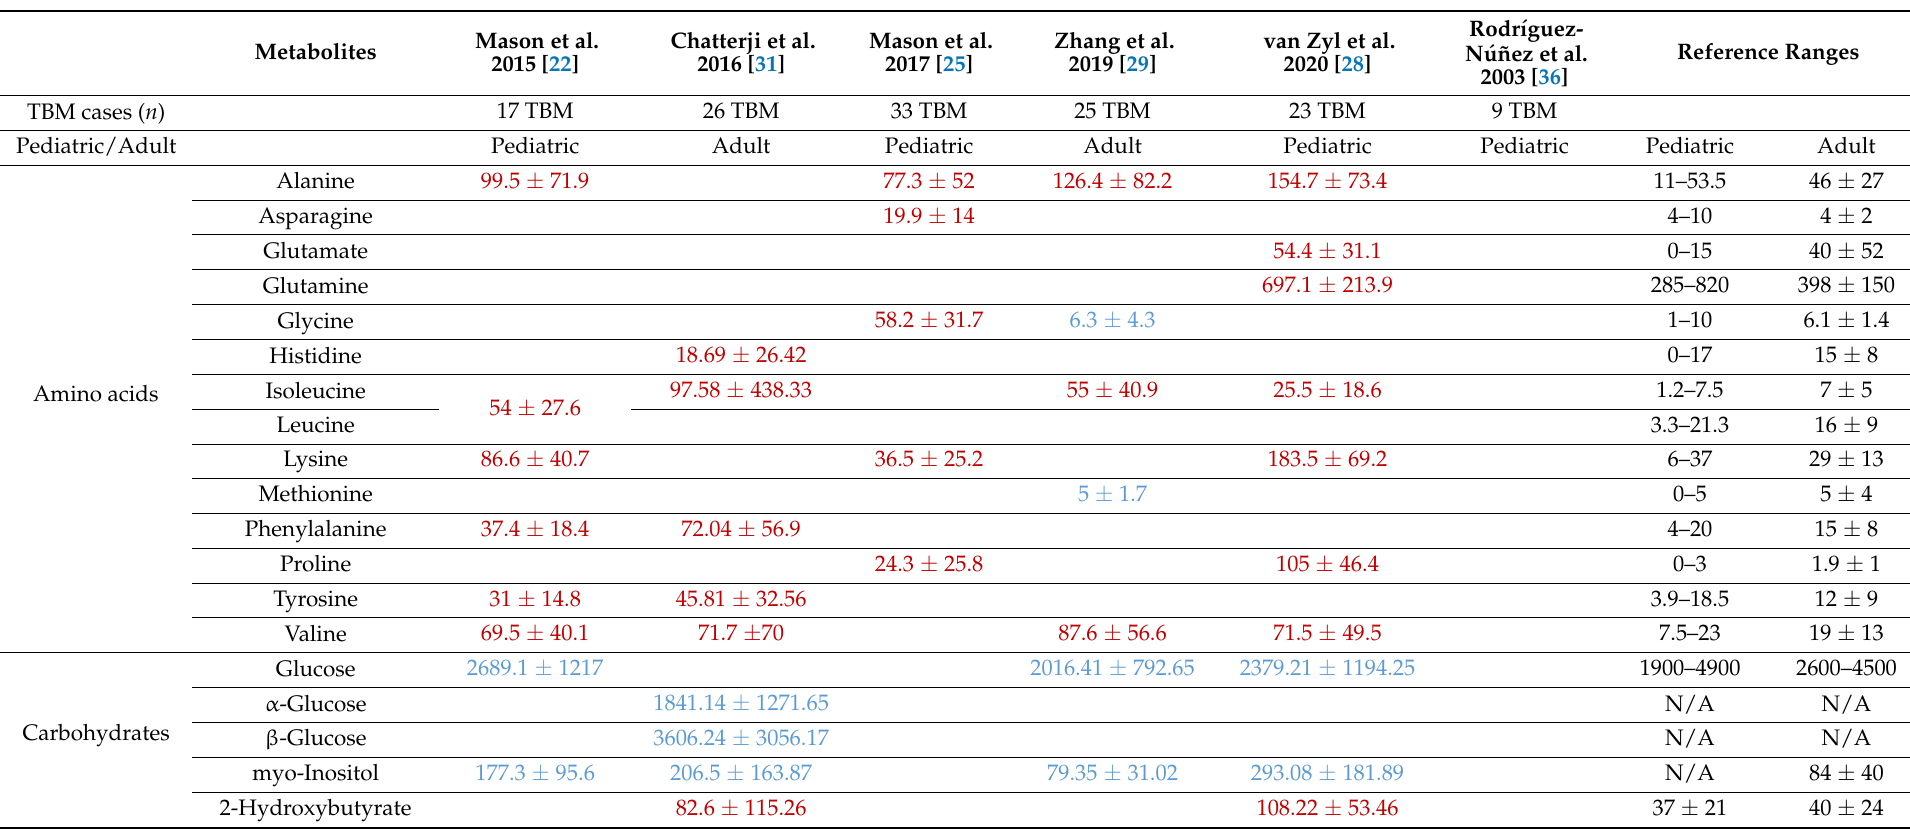
Table 1. Summary of characteristic metabolites of TBM identified by CSF metabolomics studies. All concentrations given as µ mol/L. All reference values, where available, were obtained from the Human Metabolome Database (www.hmdb.ca (accessed on 24 January 2021)) and/or Mandal et al. [49], except for glucose and lactate [50]. Red indicates elevated in TBM and blue indicates decreased in TBM. N/A = not